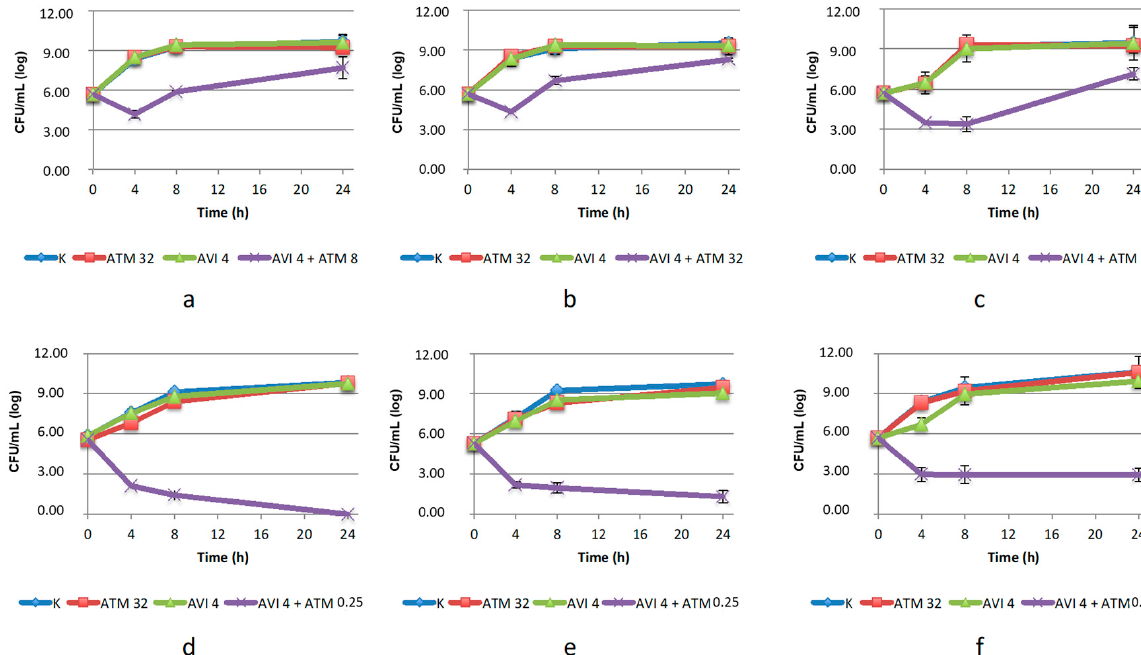
Figure 1. Twenty-four-hour time–kill curves of aztreonam (ATM) and avibactam (AVI), alone and in combination, on: ( a ) E. coli CP-Ec3; ( b ) E. coli CP-Ec4; ( c ) E. coli 482483; ( d ) C. amalonaticus N18; ( e ) K. pneumoniae KL 12 SG; ( f ) K. pneumonia LC954/14. K: positive control (without the addition of antimicrobials). Mean values and standard deviation of three independent experiments are